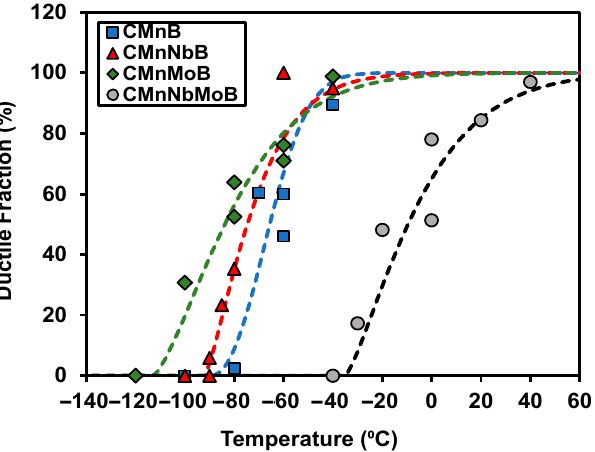
Figure 2. Effect of the addition of microalloying elements on toughness properties (ductile fraction as a function of test temperature).